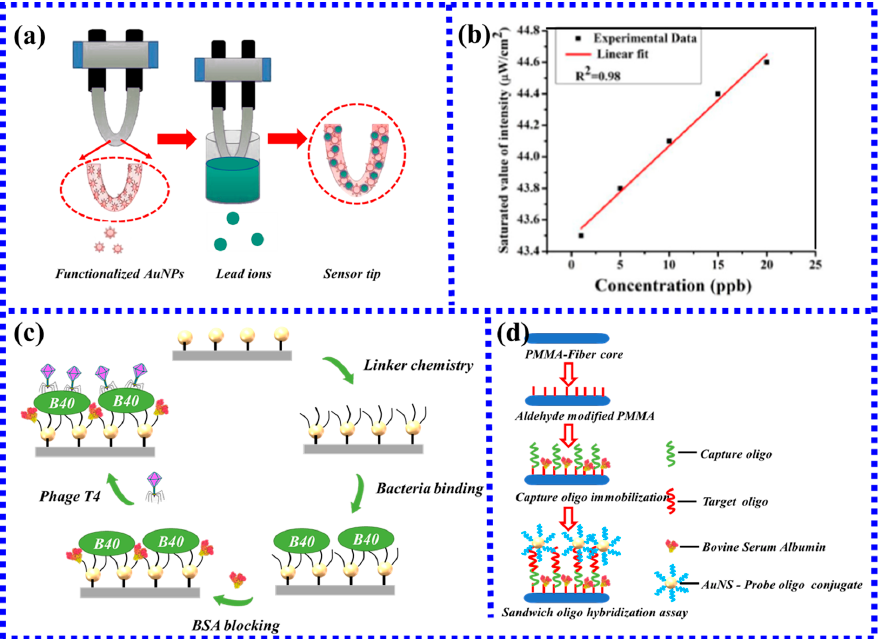
Figure 17. ( a ) The process of the probe capturing Pb 2+ [107]. ( b ) Linear fit for intensity spectrum [107]. ( c ) Functionalization of E. coli captured by T4 phage; ( d ) Assay scheme of oligonucleotides captured by sandwich DNA hybridization.